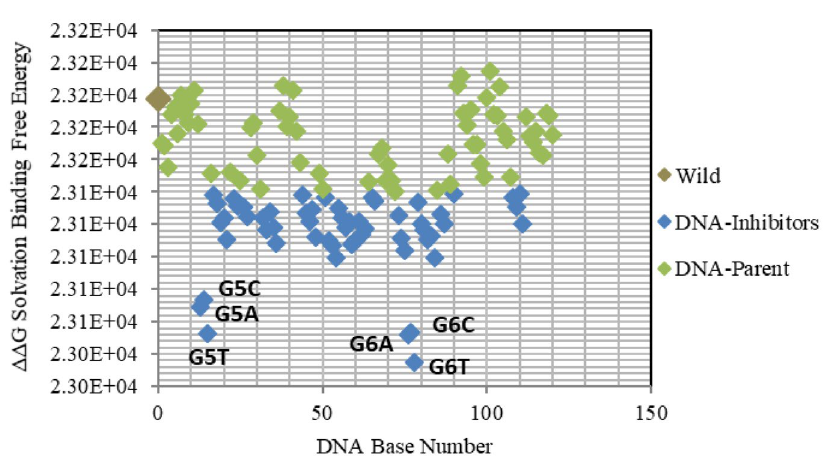
Figure 10. Electrostatic free energy differences of the DNA sequence within GATA3:DNA complex. Plot presents the solvated binding free energy calculations (in KJ/mol) of Subsequence 1 _ GATA _Subsequence 2 mutations in Strand-Y and Strand-Z. Blue colors signify basic mutants. Those mutants are predicted to reduce binding since they are shown below the parent/wild. DNA bases illustrated with labels signify the strongest inhibitors.